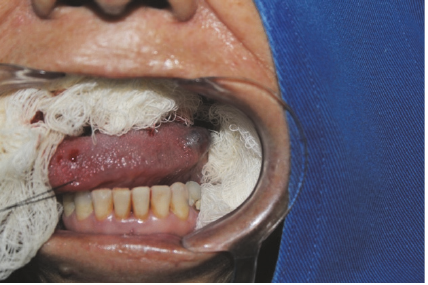
Figure 4: Tongue pulled to the right and adjacent tissues protected by gauze with Vaseline.